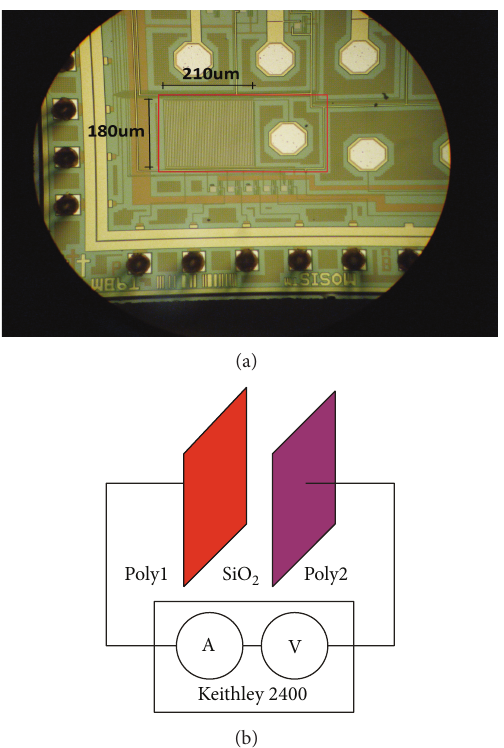
Figure 4: (a) Capacitor microphotograph. (b) Measuring equip- ment and testing